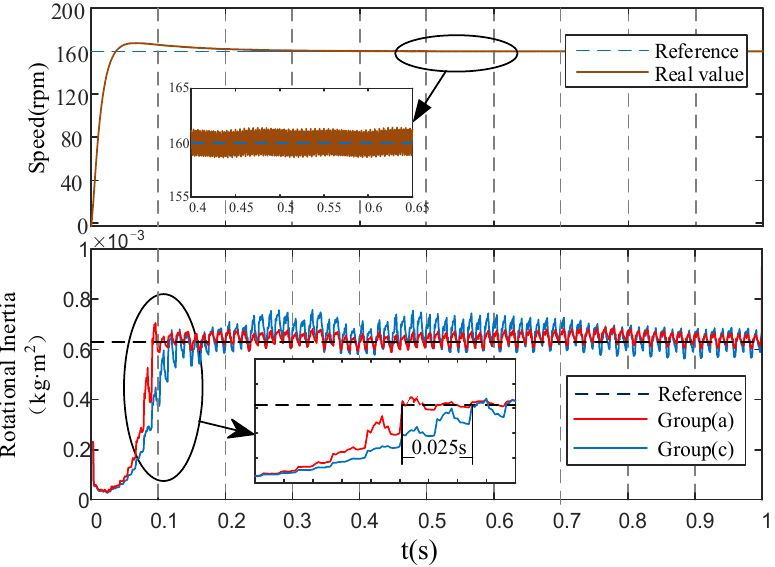
Figure 11. Steady ‐ state identification results of Experiment (ii). Figure 11. Steady-state identification results of Experiment (ii).